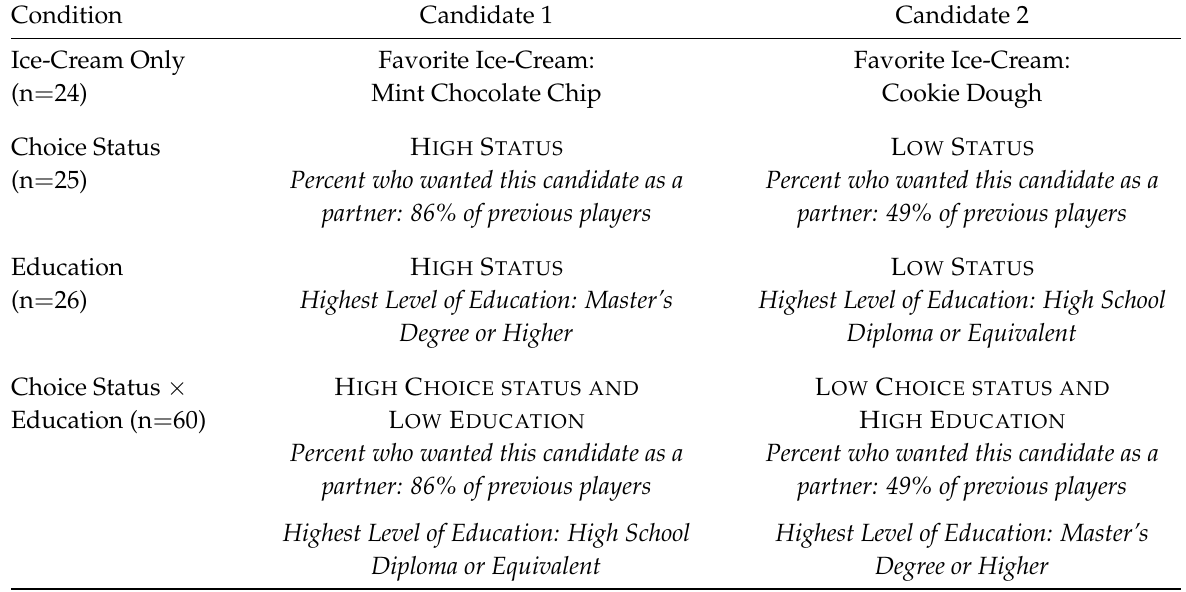
Table 2: Summary of Conditions in Study 2